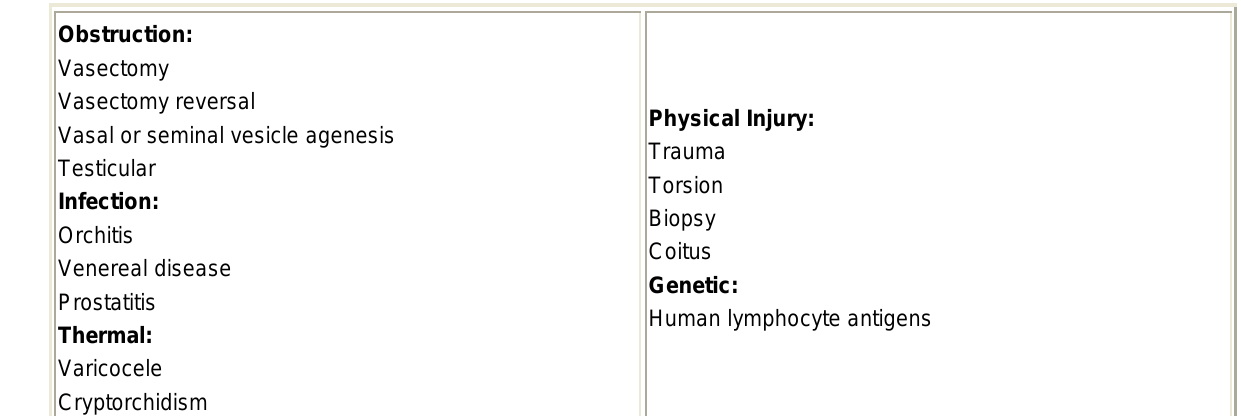
Risk Factors in the Development of Antisperm Antibodies